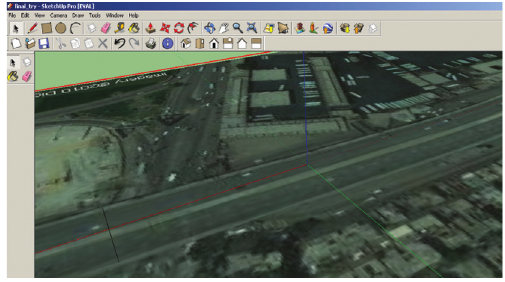
Fig. 2. Capturing construction site by Google